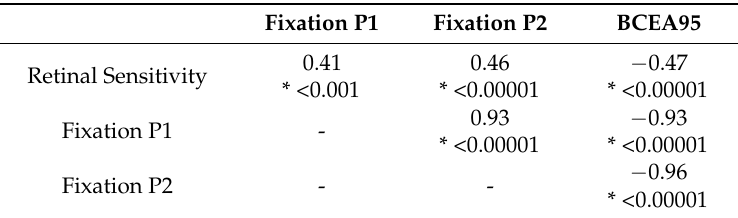
Table 3. Spearman correlation coefficients (and p values*) between retinal sensitivity and fixation parameters. Fixation P1